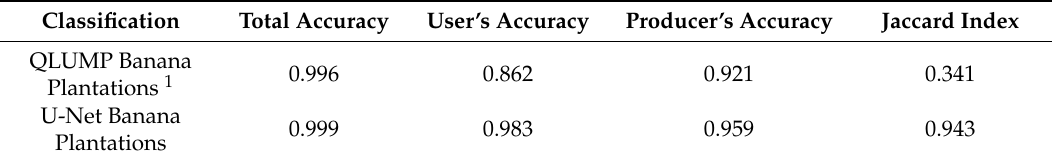
Table 1. Accuracy assessment results showing the Jaccard Index, User’s, Producer’s, and total accuracies, assessed on independent validation data. The Total, User’s, and Producer’s accuracies were based on a stratified random sample of 9805 points, 701 of which were banana plantation points. The Jaccard Index used all the validation data for the Tully River